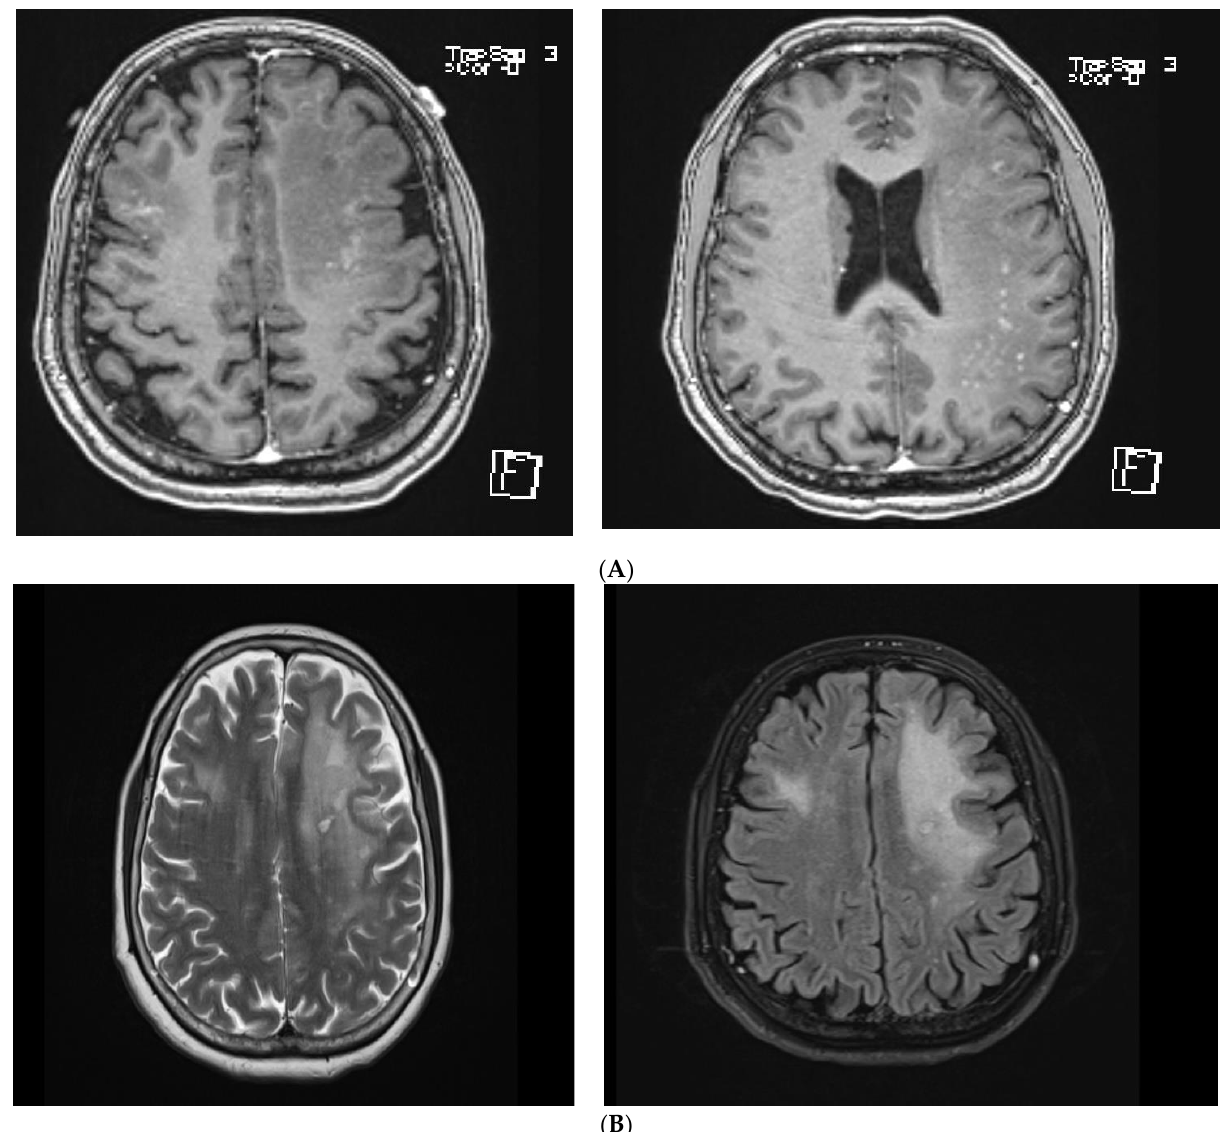
Figure 2. ( A ) T1 weighted images of MRI brain showing Bi-frontal, left parietal and temporal vasogenic oedema with associated punctate white matter contrast enhancement. ( B ) Corresponding T2/ FLAIR images of MRI brain showing Bi-frontal, left parietal and temporal vasogenic oedema.